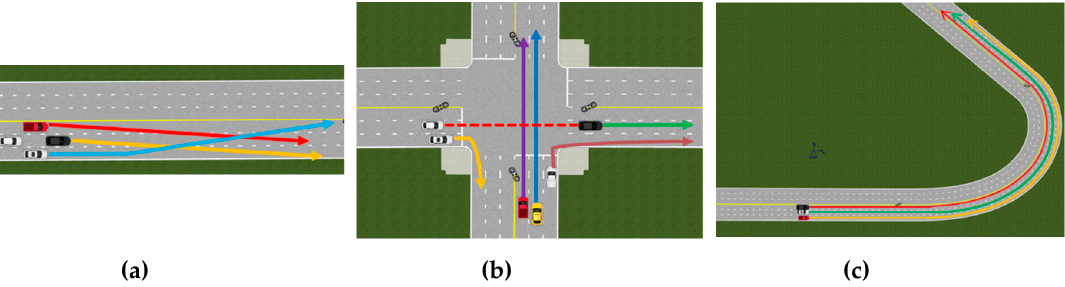
Figure 16. Simulation of three scenarios: ( a ) vehicles changing lanes; ( b ) intersection scenario; ( c ) curve scenario.